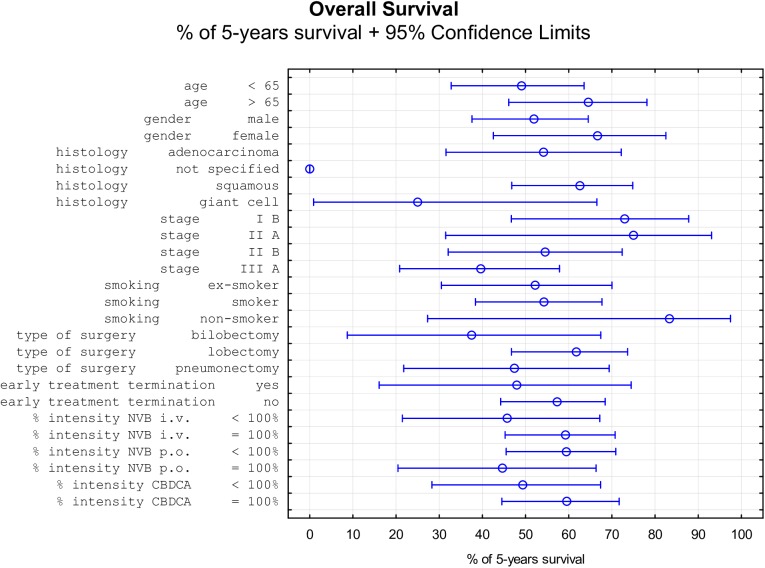
Tree plot showing percentage of 5-year overall survival with 95% confidence limits.Data presented in Fig 3 are derived from Table 1.